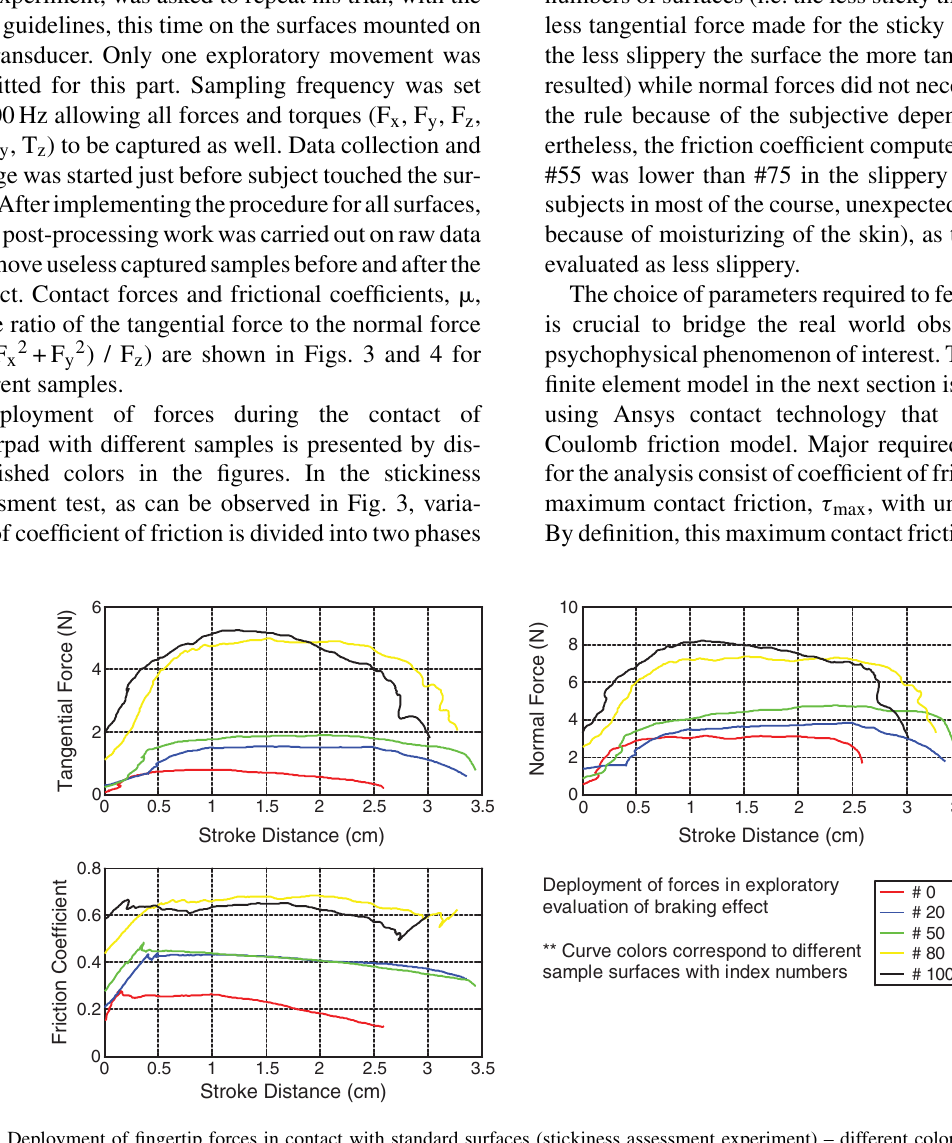
Fig. 3. Deployment of fingertip forces in contact with standard surfaces (stickiness assessment experiment) – different colors correspond to different sample surfaces with indicated index numbers (same as psychophysical